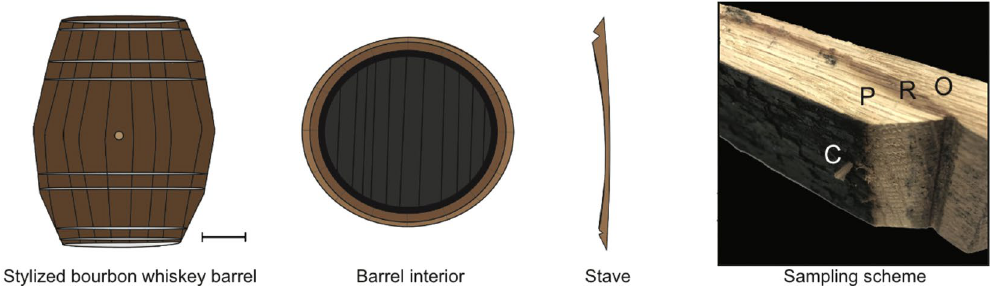
Figure 1. The composition of a bourbon whiskey barrel. Diagrams showing a stylized bourbon whiskey barrel (scale bar: 15 cm), a cross section of the charred barrel interior and a stave. The sampling scheme highlights the charred surface of the barrel stave (C); the inner portion of wood, which undergoes thermal degradation and distillate penetration (P); the red line (R), which indicates the depth to which the distillate penetrated the stave; and the outer portion of the stave (O). Note that the thickness of the red line and its distance from the outside of the stave vary both within the stave and among